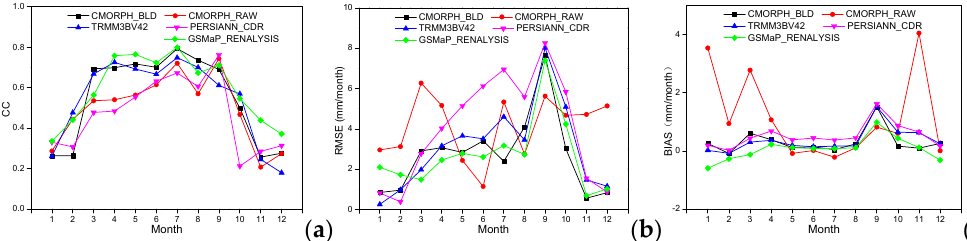
Figure 10. ( a – c ) denote the CC, RMSE and BIAS among a variety of products for each month in 2013 over the Tibetan Plateau, respectively.